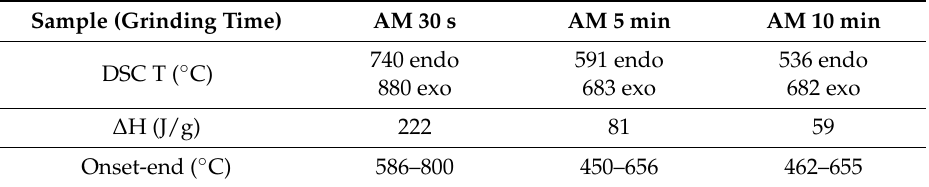
Table 3. Main peak temperatures for DSC curves and ∆ H dehy for amosite (AM) after grinding for 30 s, 5 min and 10 min, endo = endothermic, exo = exothermic. The area under the endothermic peak ( ∆ H dehy ) is delimited in the range onset-end.